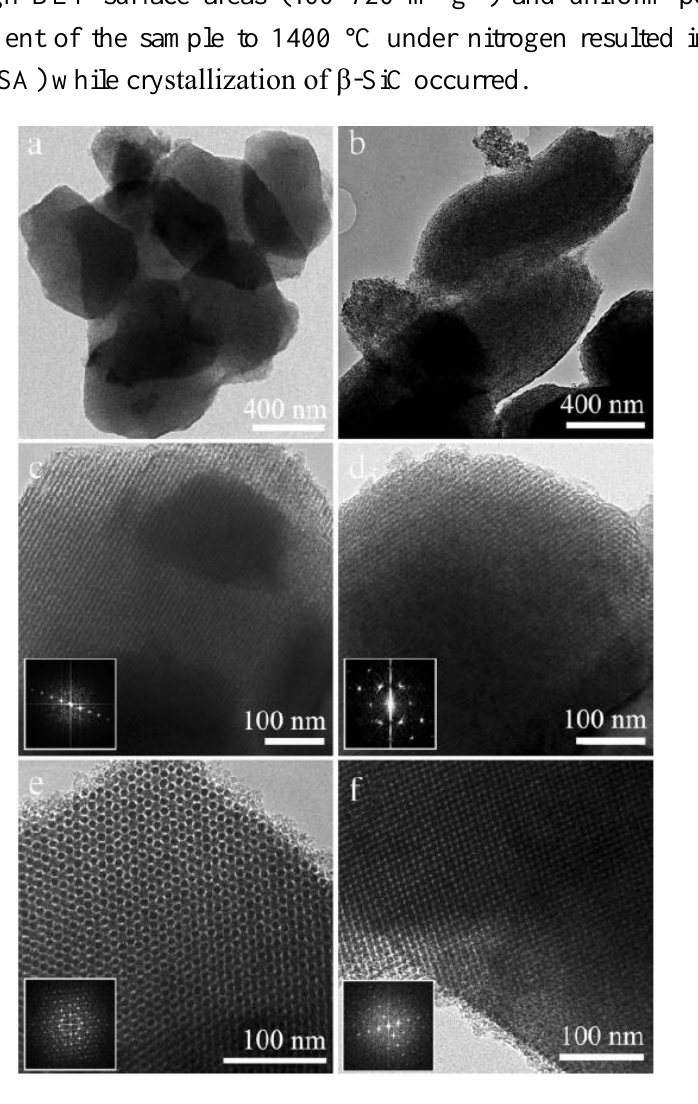
Figure 9. TEM images of ordered mesoporous SiC obtained by pyrolysis at 1200 °C from SBA-15 (silica-based Santa Barbara amorphous material No. 15) at low magnification ( a , b ) and high magnification ( c , d ) taken along the ( c ) (110) and ( d ) (100) directions. TEM images of ordered mesoporous SiC obtained by pyrolysis at 1400 °C from KIT-6 (Korea Advanced Institute of Science and technology No. 6) taken along the ( e ) (111) and ( f ) (531) directions. Insets show the corresponding Fourier diffractograms (reprinted with permission from reference [233]; Copyright